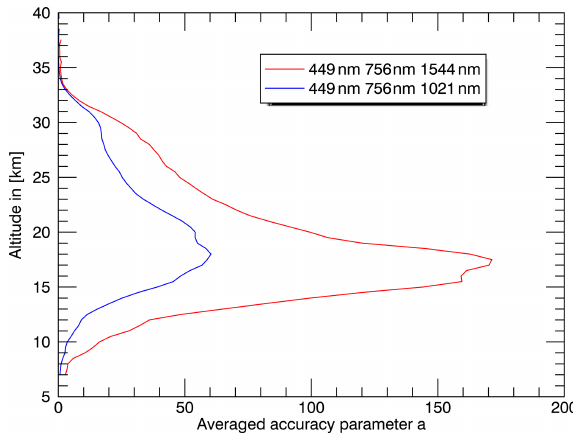
Figure 5. Profiles of the accuracy parameter a averaged over the first 3000 solar occultation events of SAGE III/ISS for the wave- length combination 449/756/1544nm (red) and 449/756/1021nm